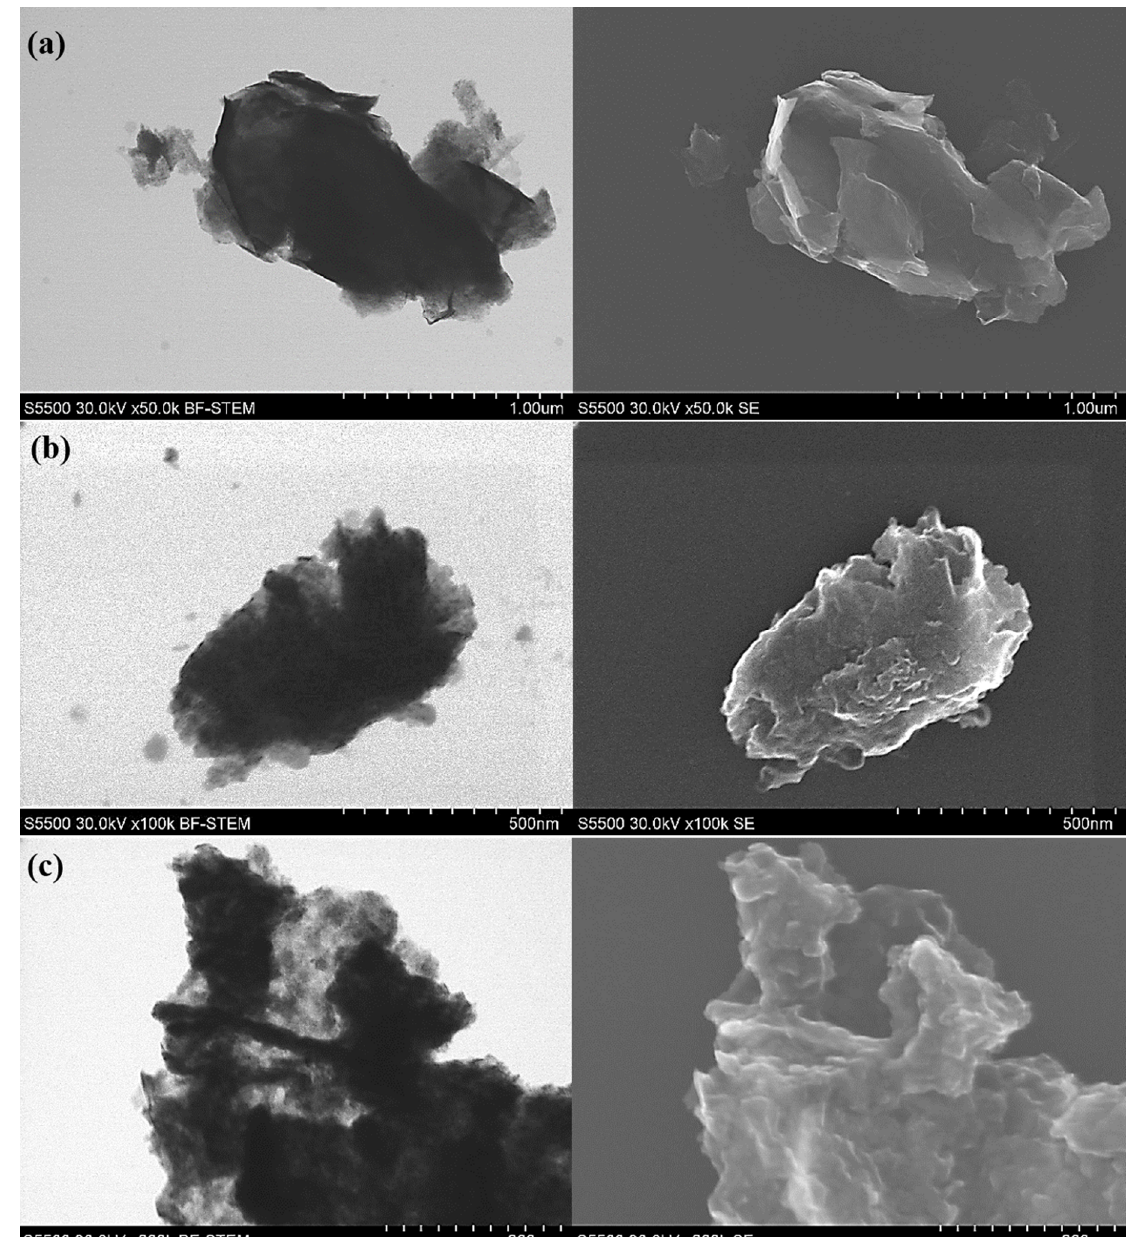
Figure 9. Images of MoS 2 /GO form in the semi-batch reactor in weight ratios of ( a ) 10:1, ( b ) 30:1, ( c ) 50:1 in SE and BF-STEM modes.